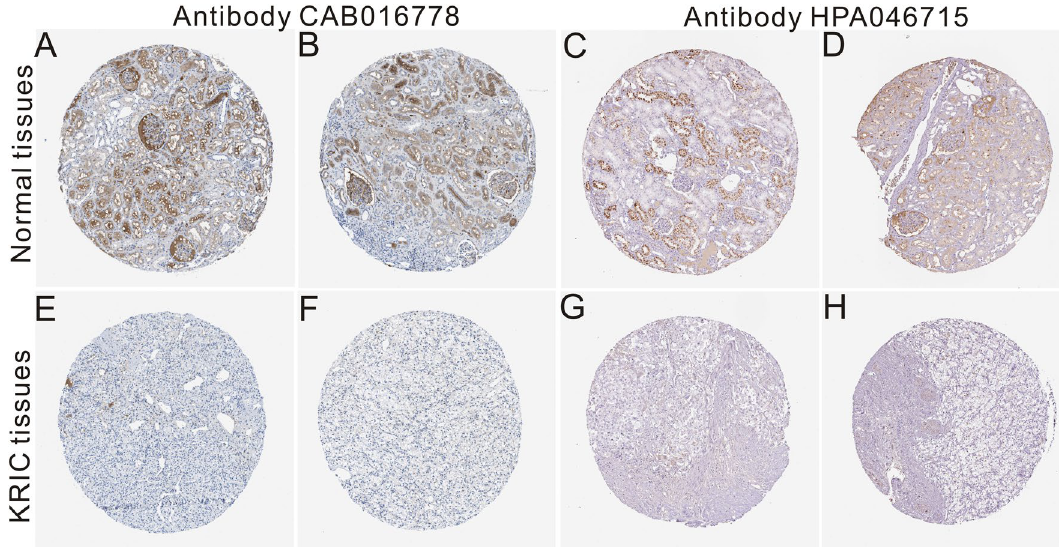
Figure 3. Representative images stained with APOA1 antibody (CAB016778; HPA046715), which were downloaded from the HPA database (https:// www. prote inatl as. org/). ( A – D ) The normal tissues. ( E – H) KIRC tissues. HPA046715 is a polyclonal antibody derived from rabbits and produced by Sigma-Aldrich, and CAB016778 is a monoclonal antibody derived from mice and produced by BioPorto Diagnostics